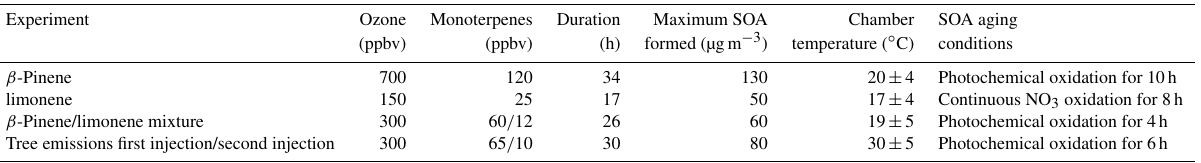
Table 1. Experimental conditions during each ozonolysis experiment. Two VOC injection periods were performed for the tree emissions experiment. Experiment Ozone Monoterpenes Duration Maximum SOA Chamber SOA aging (ppbv) (ppbv) (h) formed (µgm − 3 ) temperature ( ◦ C) conditions β